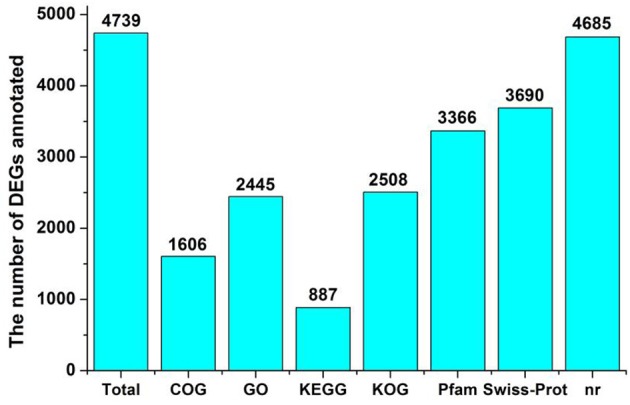
The number of DEGs annotated.